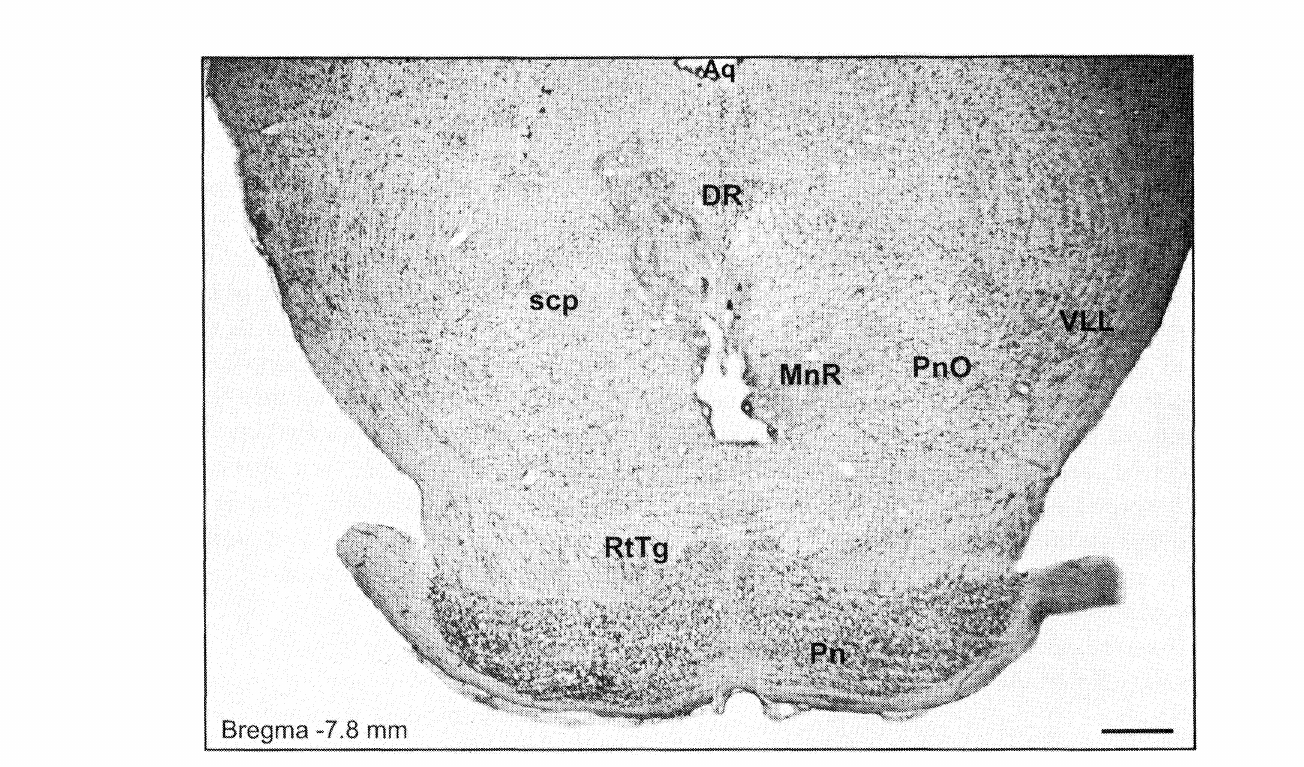
Fig. 1" Photomicrograph showing a typical example of electrolytic lesions of the median raphe nucleus. The section shown is -7.8 mm behind bregma according to the Paxinos and Watson atlas (1997). MnR median raphe nucleus, scp= superior cerebellar peduncle, PnO pontine reticular nucleus, DR dorsal raphe nucleus, Pn pedunculopontine nucleus, VLL ventral nucleus of the lateral lemniscus, RtTg Reticulotegmental nucleus of pons, Aq aqueduct. Bar=350